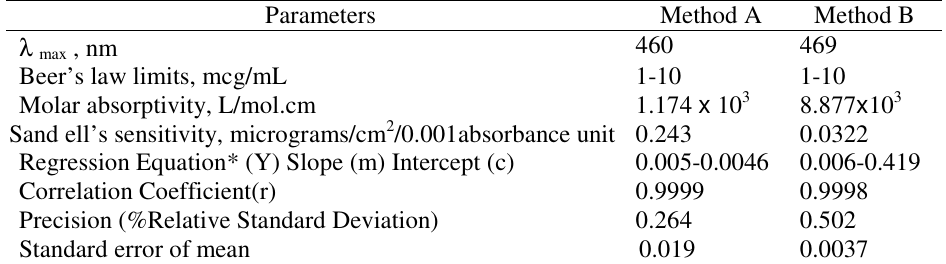
Table 2. Optical characteristics and precision